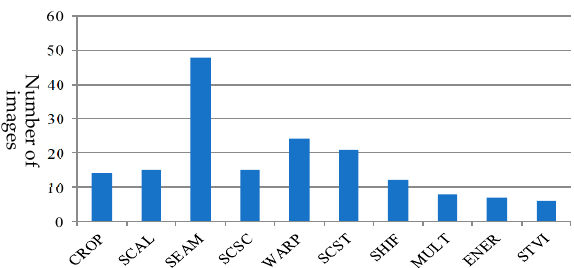
Figure 4. Quantitative chart of the images obtained by using different retargeting algorithms in the CUHK database.